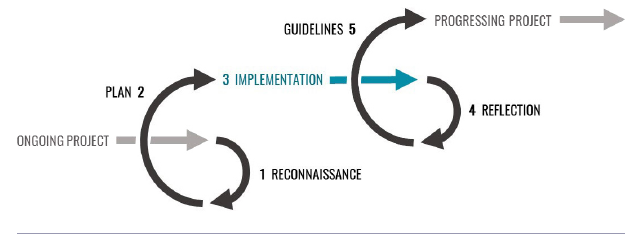
Fig. 1 . Cyclical protocol of the research: exploring the context (reconnaissance), planning future activities, implementing the plan, reflecting upon the results, and refining the